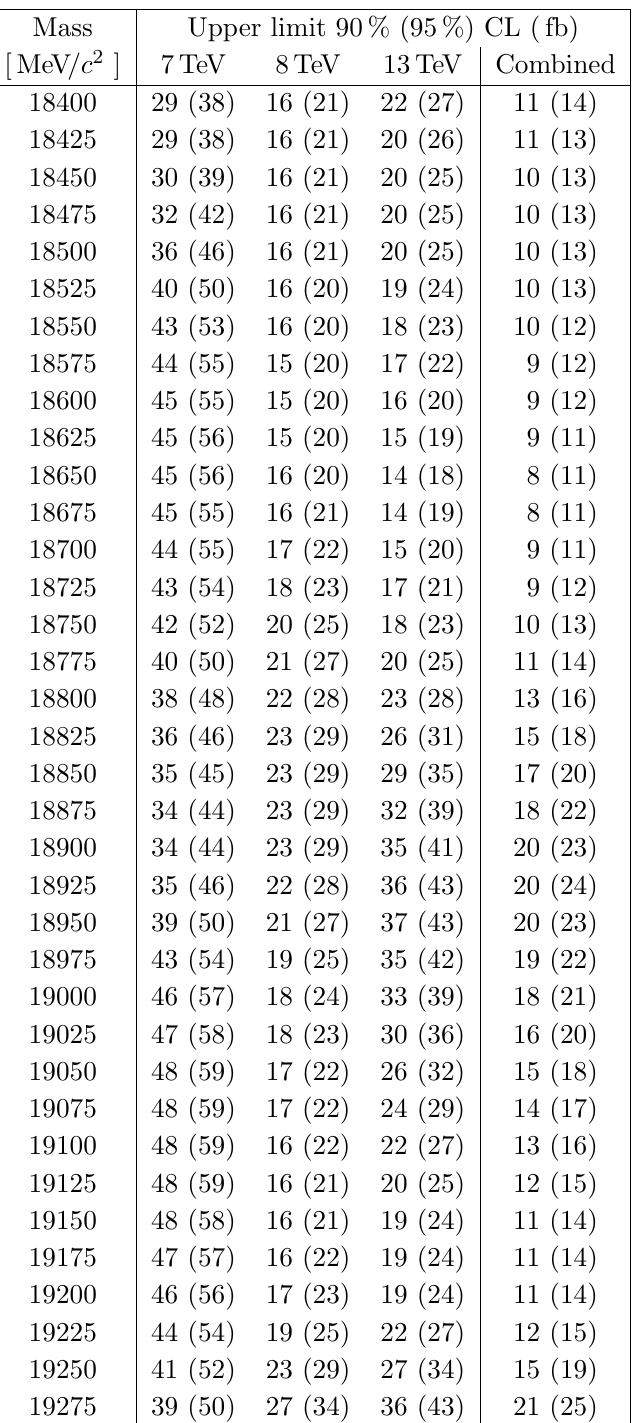
Table 2 . Upper limits on (cid:27) ( pp ! X ) (cid:2) B ( X ! (cid:7) (1 S ) (cid:22) + (cid:22) (cid:0) ) (cid:2) B ( (cid:7) (1 S ) ! (cid:22) + (cid:22) (cid:0) ) for di(cid:11)erent X mass hypotheses in the range [18 : 4 ; 19 : 3] GeV =c 2 .